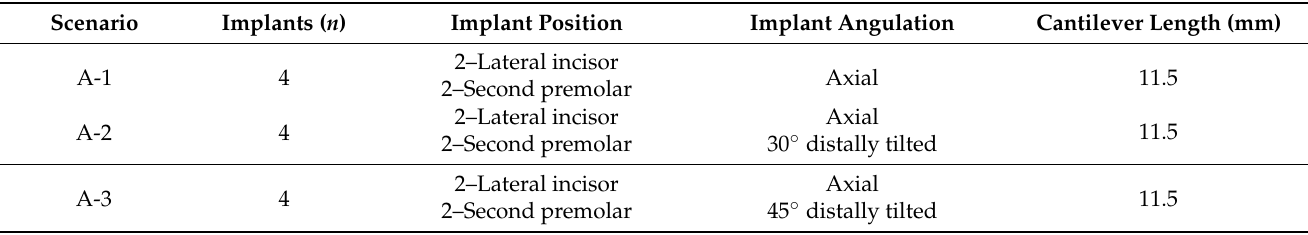
Table 1. Different scenarios, number, location, angulation of implants, and distal cantilever length of the